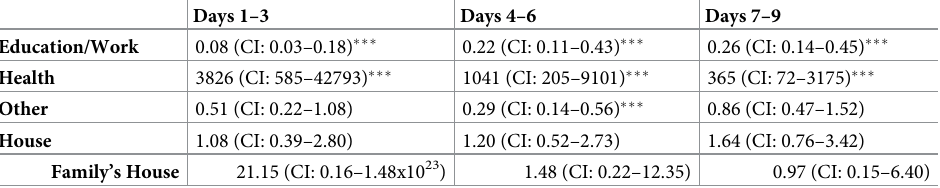
Table 2. Adjusted odds ratios (and 95% Confidence Intervals) for location type during illness, derived from logis- tic GLMMs.